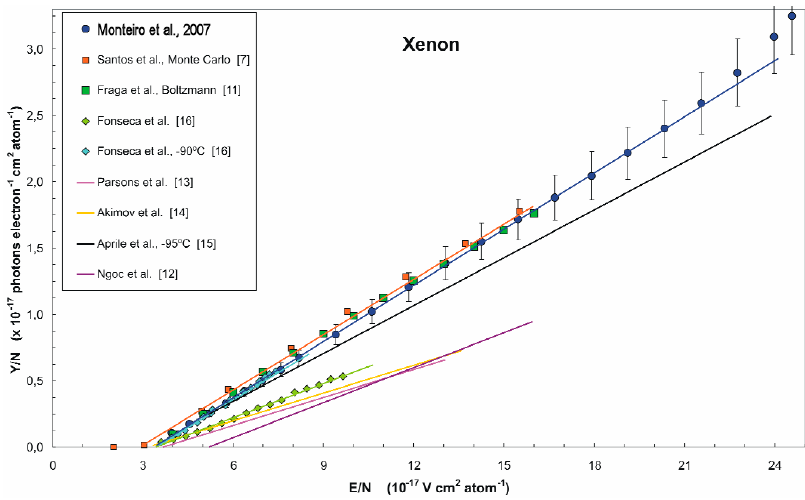
Figure 6. Reduced EL yields for ordinary (excimer) EL in Xe measured by different groups, as a function of the reduced electric field [17]. The references in the figure are those of [17].